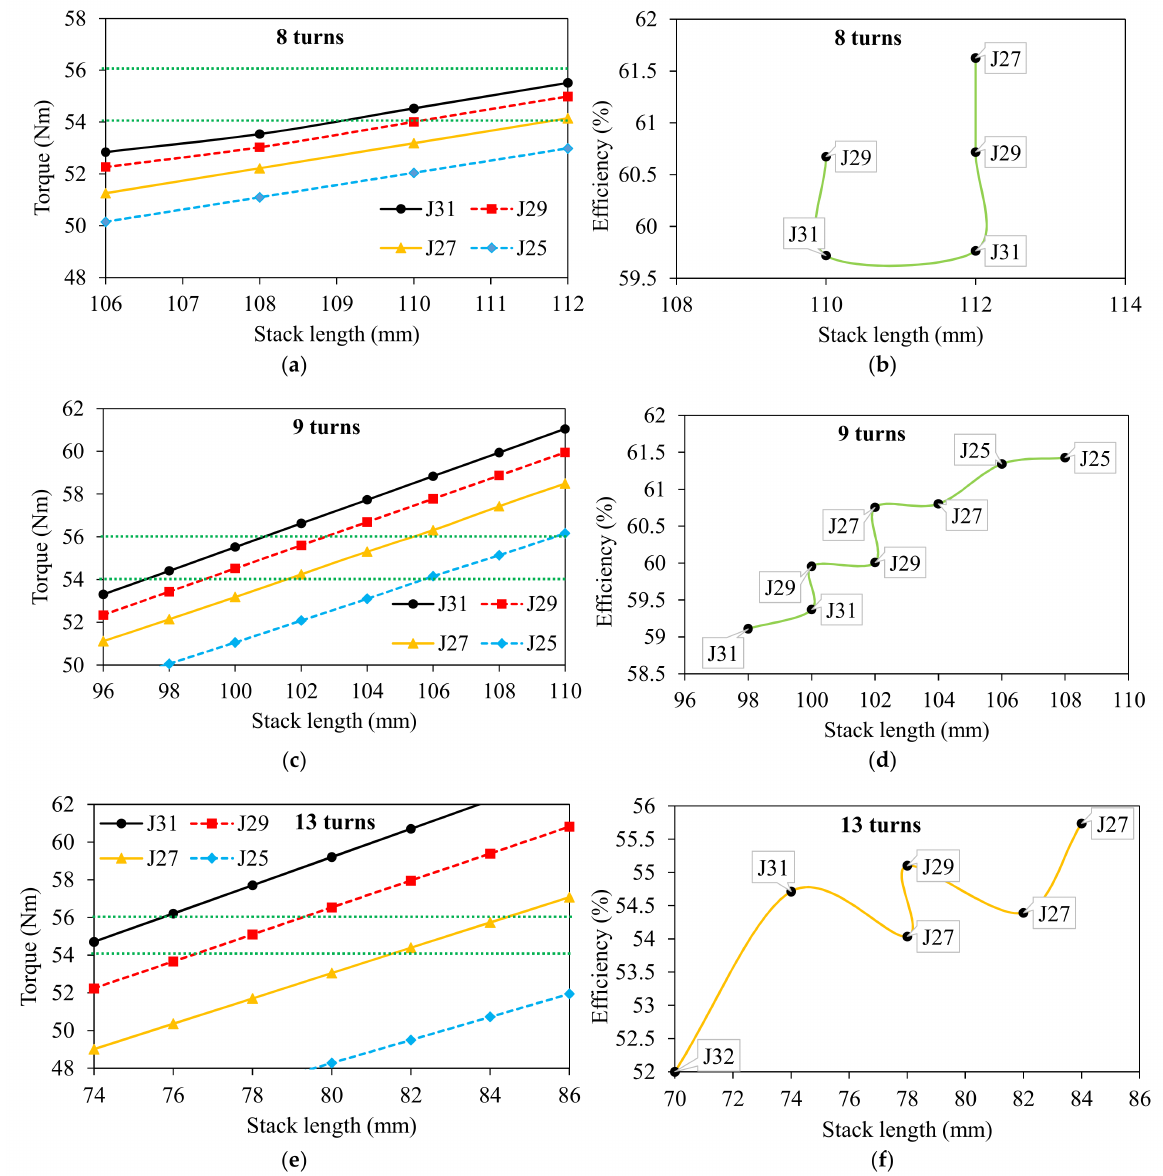
Figure 28. Variation of torque and efficiency for different current density amounts: ( a , b ) 8 turns per phase, ( c , d ) 9 turns per phase, and ( e , f ) 13 turns per